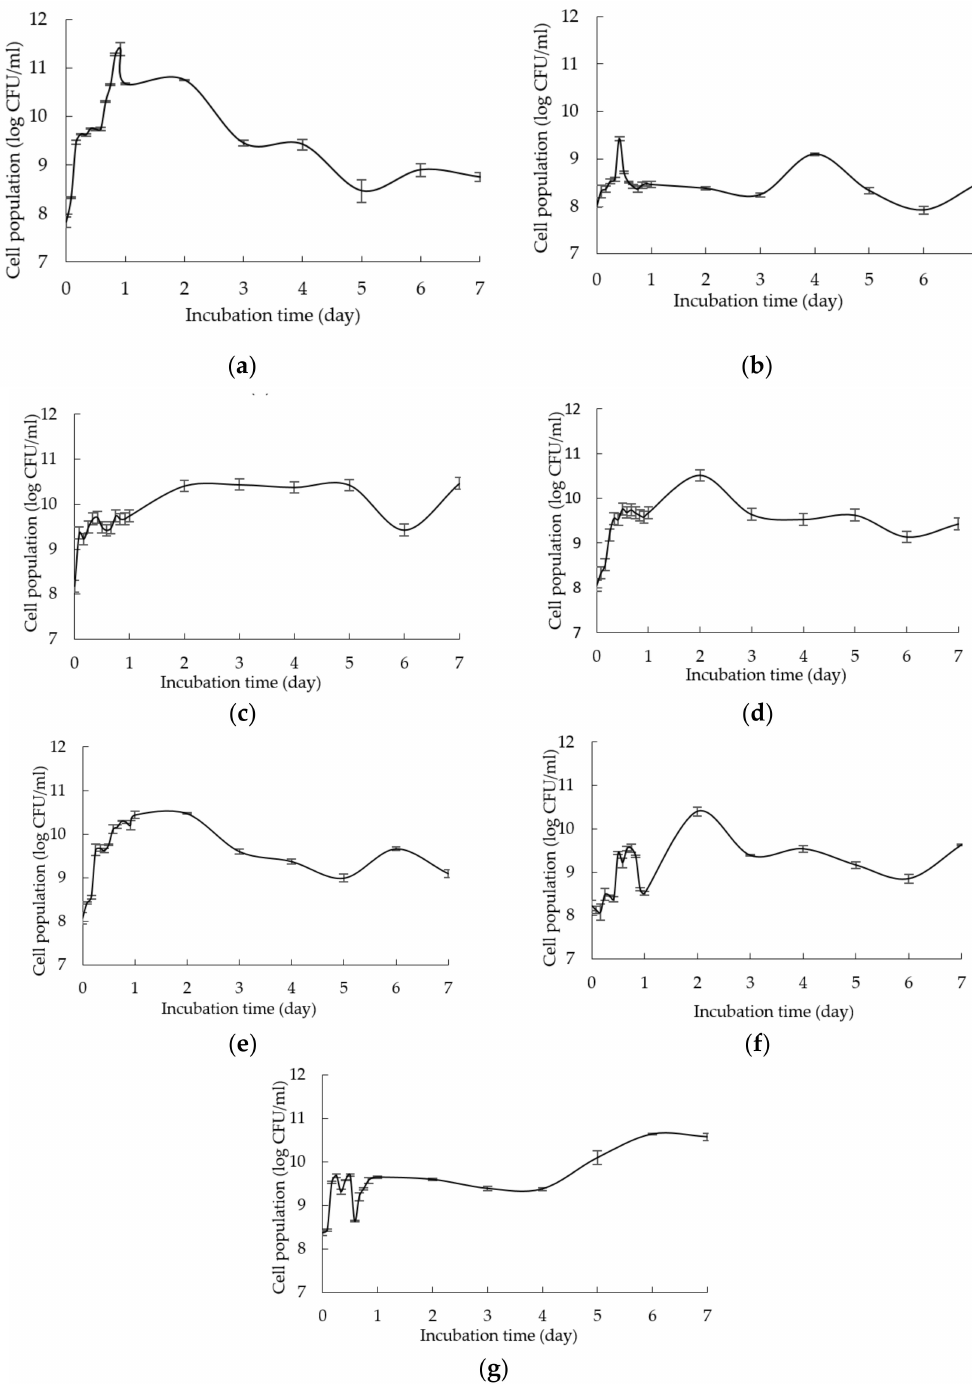
Figure 1. Growth profile of Lactobacillus plantarum RI 11 in: ( a ) control MRS medium ( b ) M1; rice straw and yeast extract ( c ) M2; rice straw and soybean pulp ( d ) M3; molasses and yeast extract ( e ) M4; molasses and soybean pulp ( f ) M5; PKC and yeast extract and ( g ) M6; PKC and soybean pulp. The error bars represent the standard deviation of cell population of triplicate samples ( n = 3).